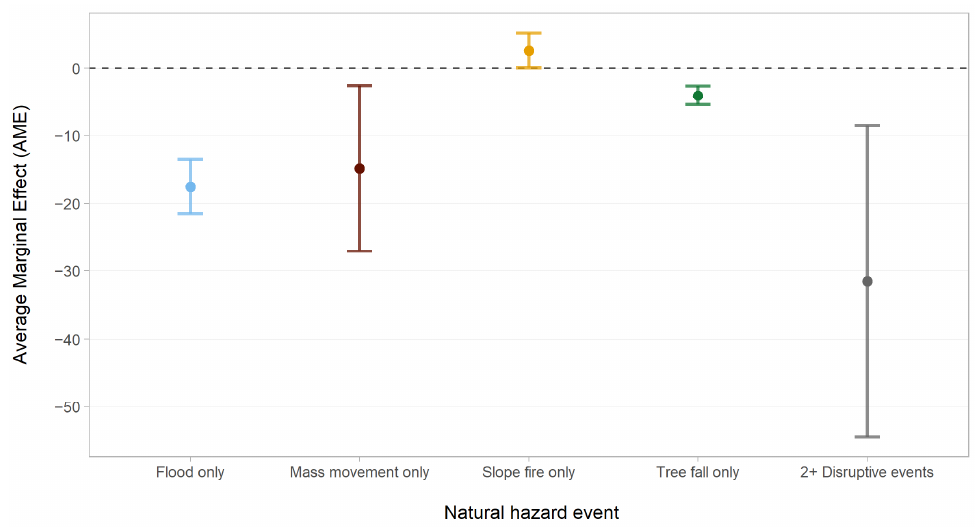
Figure 5. Average marginal effects of natural hazards on traffic in the negative binomial regression.